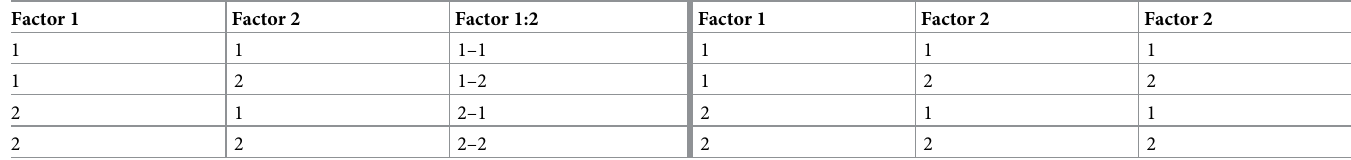
Table 3. While Hierarch cannot produce p- values and confidence intervals for interaction effects, it can account for interactions when estimating main effects. Factor 1